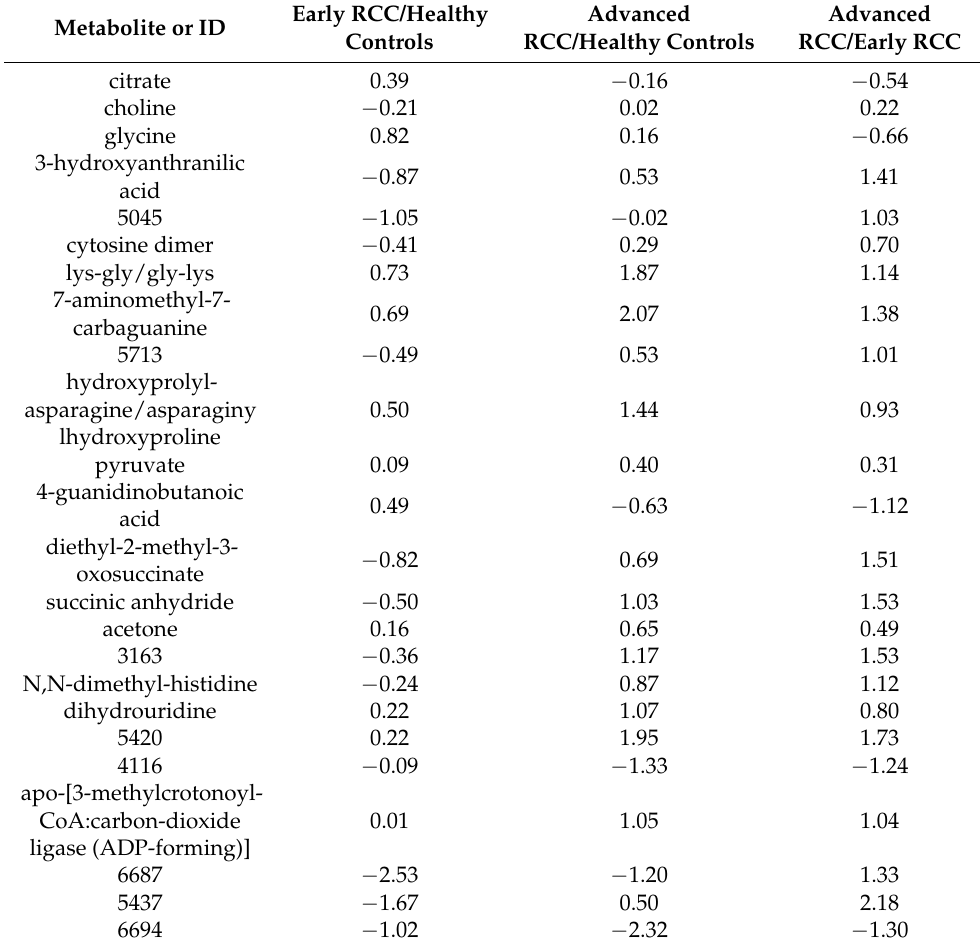
Table 5. Comparison of early-stage and advanced-stage RCC with healthy controls using the RCC staging markers. Fold change (FC) was calculated as the base two logarithm of the average intensity ratios between two groups. Early RCC/Healthy Advanced Advanced Metabolite or ID Controls RCC/Healthy Controls RCC/Early RCC citrate 0.39 choline − 0.21